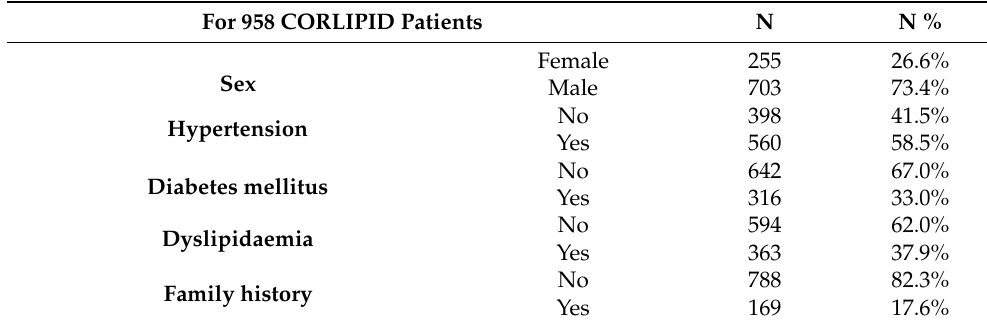
Table 1. Baseline clinical and demographic characteristics of the CorLipid